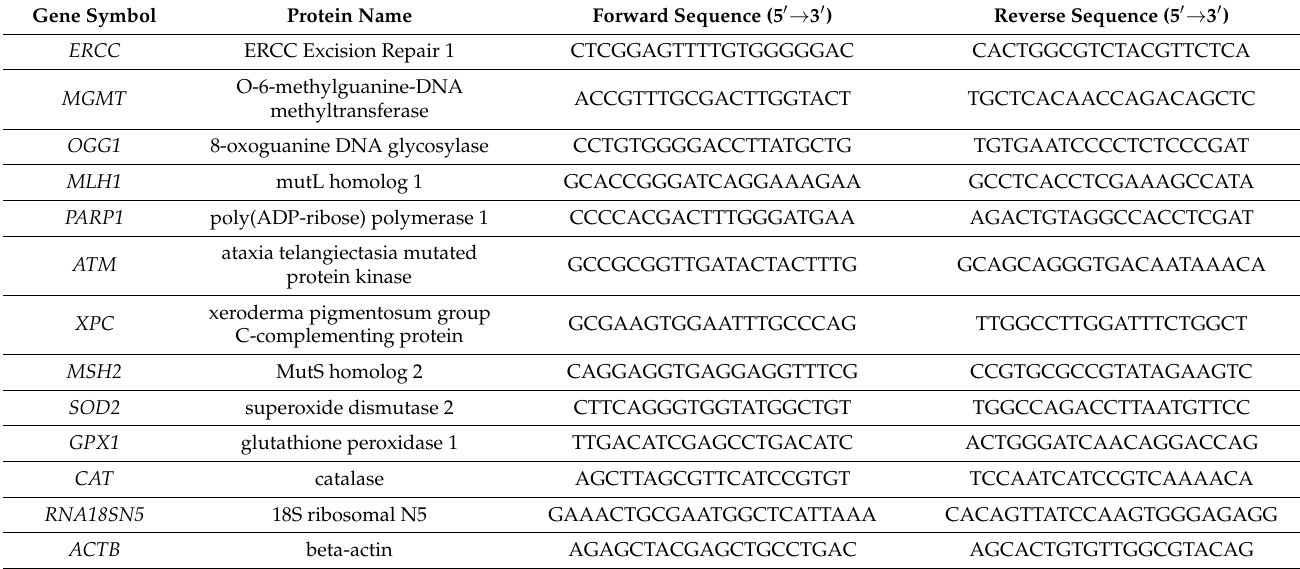
Table 5. Primers used in gene expression